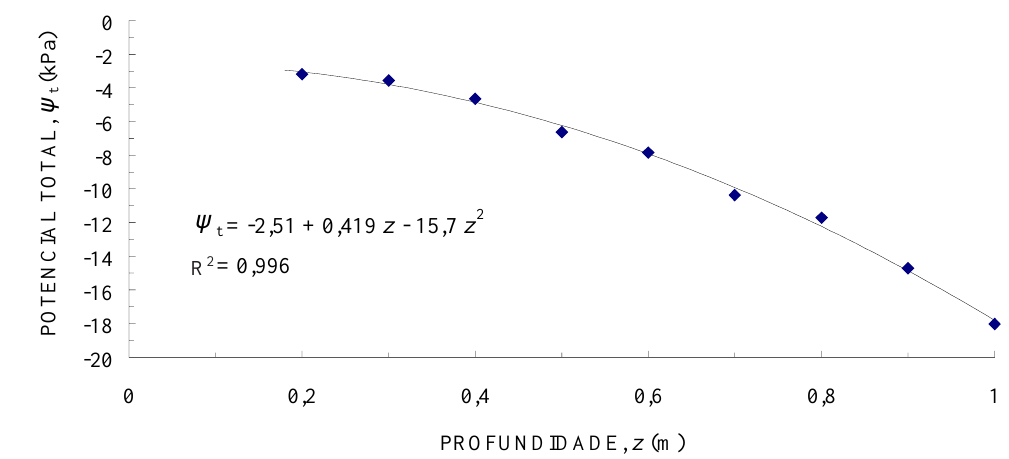
Figura 3. Ajuste à equação 8 dos dados do local 9 e tempo de 110,3 h.